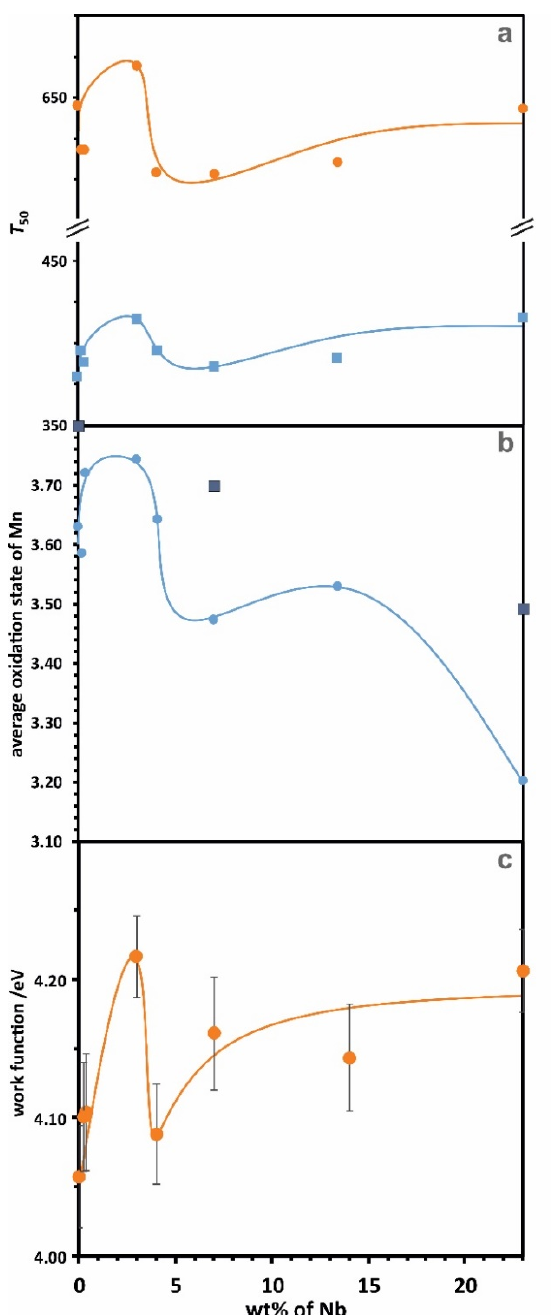
Figure 7. Activity of the investigated catalysts in soot combustion, denoted as the temperature of 50% conversion in the tight (blue line) and loose (orange line) contact, as a function of the concentration of niobium dopant ( a ) together with the average oxidation state of surface manganese derived from XPS (circles) and bulk manganese derived from XAS (squares) measurements ( b ) and work function ( c ).